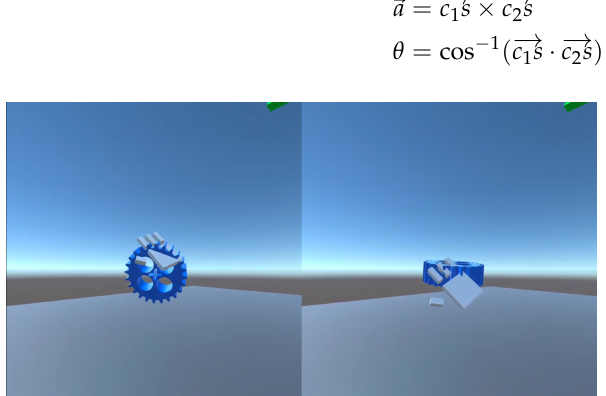
Figure 5. Free rotation.